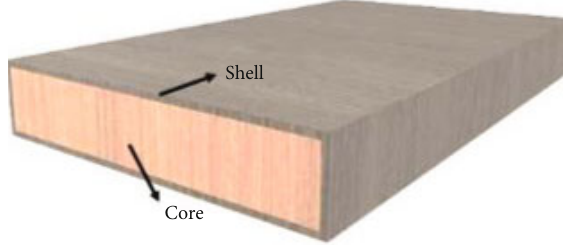
Figure 1: Coextruded core-shell WPCs with a talc- fi lled shell